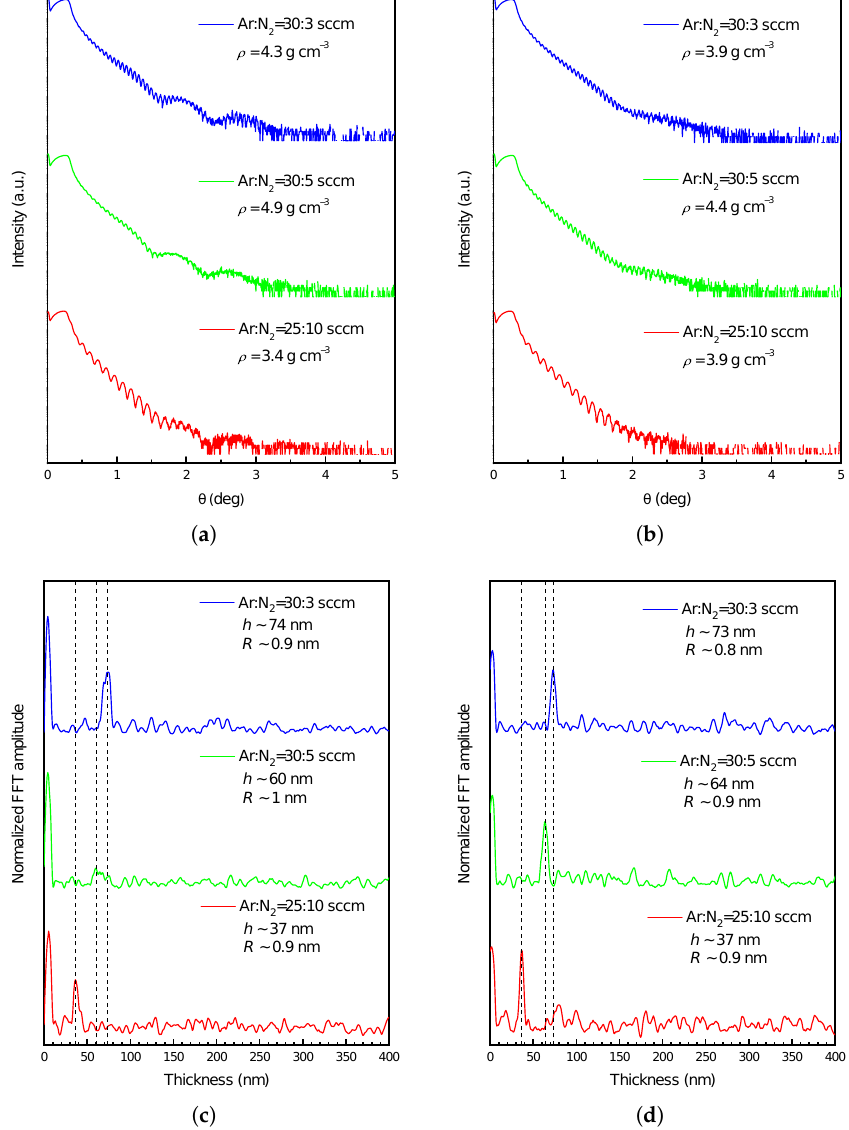
Figure 3. X-ray reflectivity (XRR) spectra for as-deposited TiN films processed under different Ar:N 2 flow rates on ( a ) Si and ( b ) SiO 2 substrates; the density, ρ , is calculated from the critical angle. Fast Fourier transform (FFT) spectra of ( c ) the films on Si substrates and ( d ) the films on SiO 2 substrates; h represents the film thickness and R is the surface